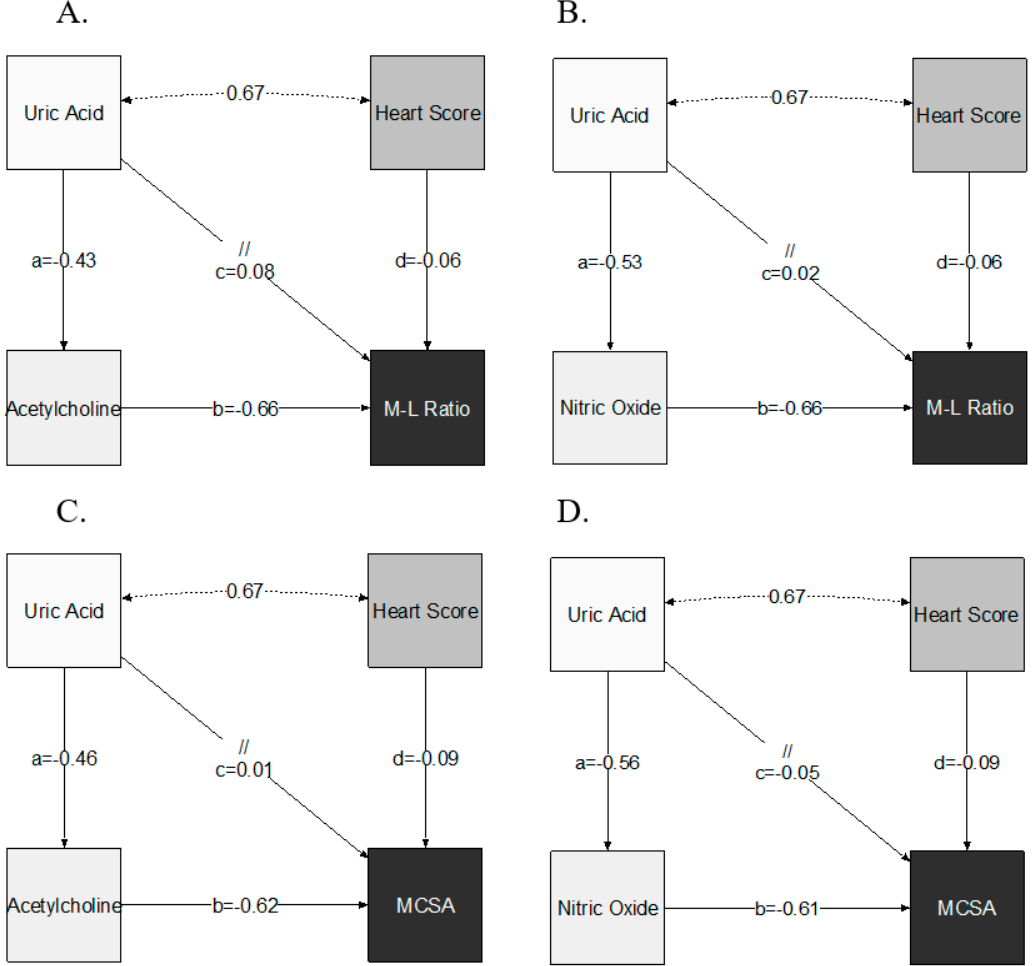
Figure 2. Path diagrams for structural equation models of the mediating effect of endothelial function (( A ) and ( C ): Acetylcholine; ( B ) and ( D ): NO availability) on the association between uric acid levels and indices of microvascular remodeling (A and B: M/L ratio; C and D: MCSA). Endothelial function was available in 70 subjects. In each path diagram, independent variables have unidirectional arrows pointing to the dependent variable. The parameter coefficient that has been estimated by the SEM models is placed adjacent to corresponding arrows. Coefficients a and b indicate the indirect effect (a*b) whilst coefficient c quantifies the direct effect. Double headed arrows represent the covariance estimation between uric acid levels and the Heart Score.